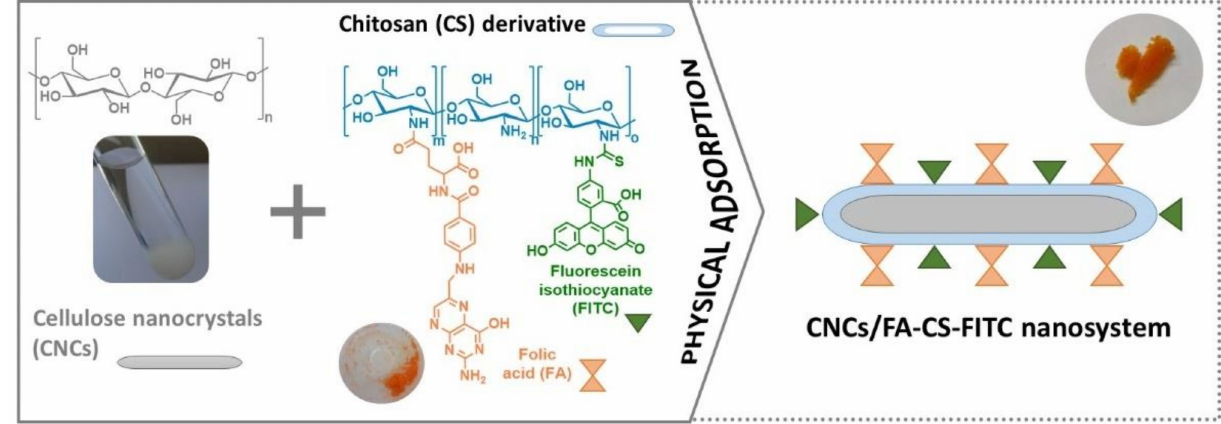
Figure 1. Scheme representing the preparation of the CNCs/FA-CS-FITC